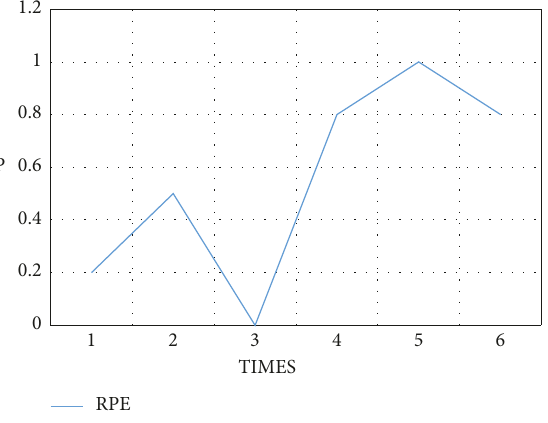
Figure 8: Trend of P value of RPE in weeks Table 5: Statistical table of correlation between physiological indicators and psychological indicators in the 10th to 12th weeks (Pearson’s coefficient r ).